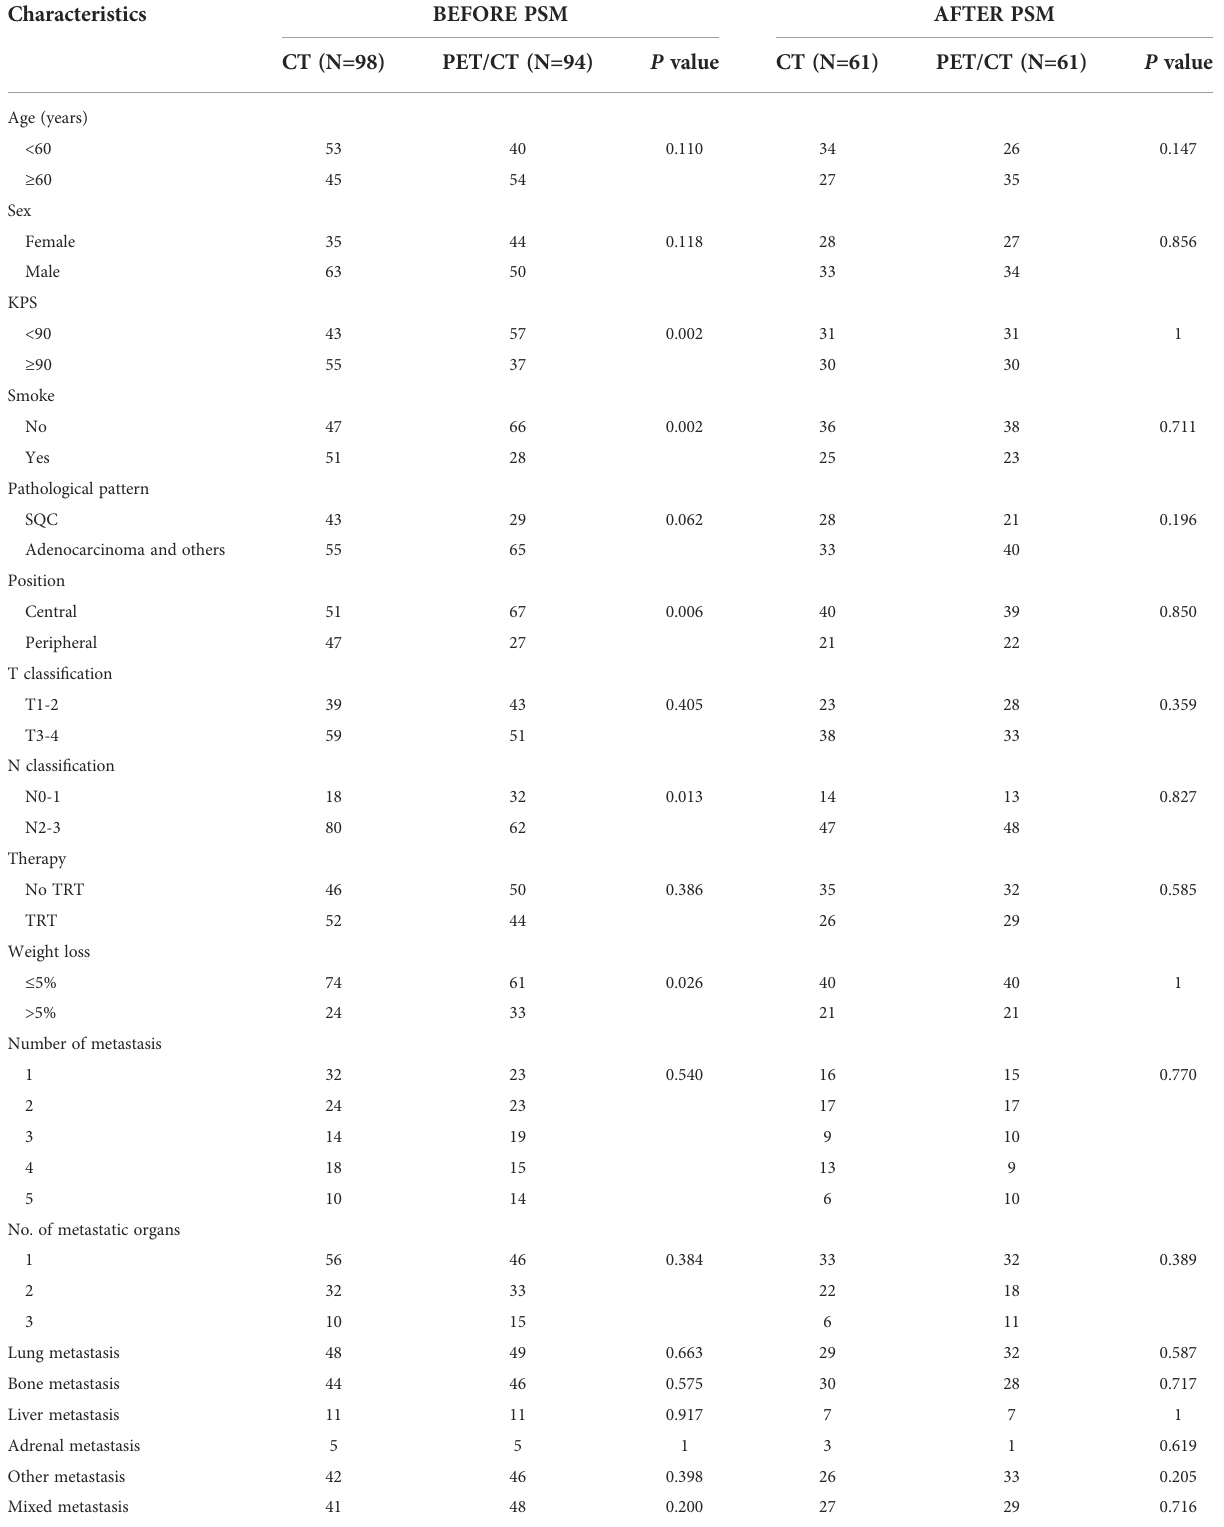
TABLE 1 Baseline characteristics of